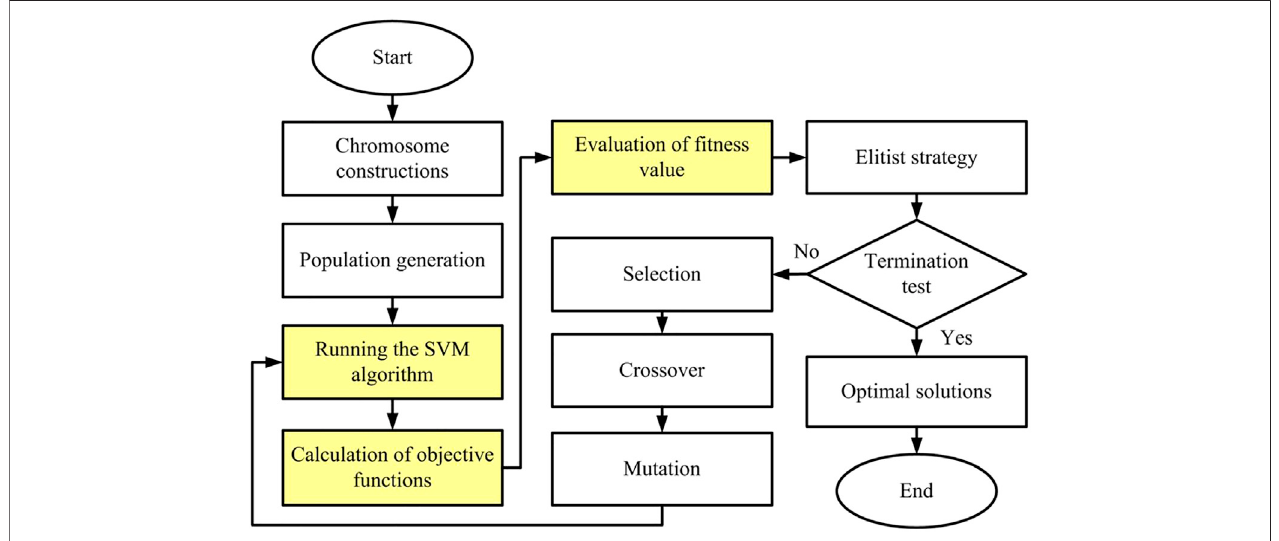
FIGURE 6 | Flowchart of the inundation forecasting model integrating the support vector machines with multi-objective genetic algorithm (Jhong et al., 2016).